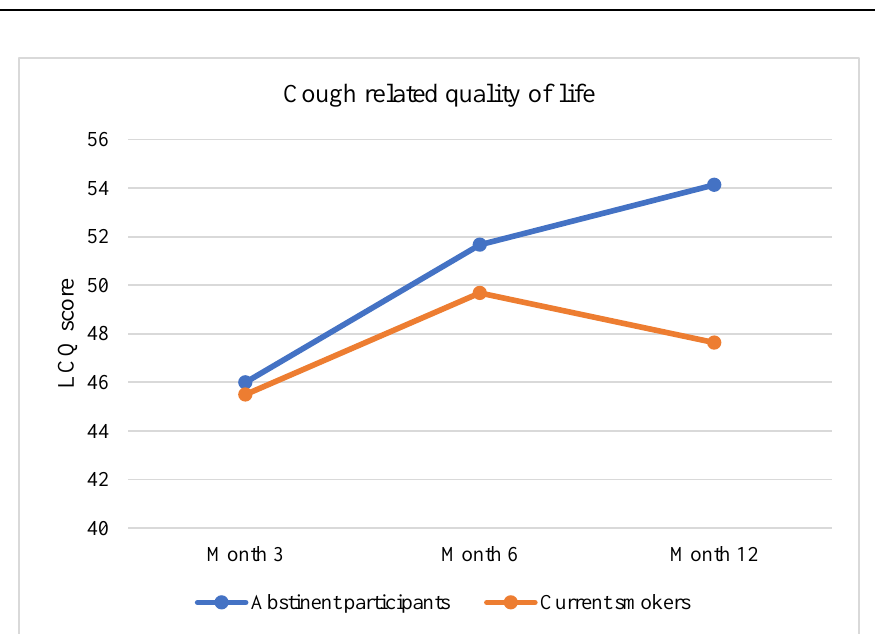
Figure 3. Change in anxiety level as measured by HAD subscale throughout the study Burning throat decreased from 6 to 12 months, which may be considered the only relevant symptom potentially related to the habitual use of e-cigarettes (Table 3). Table 3. Side-effects. Here we describe participants ’ subjective reports about e-cigarettes ’ side-ef- fects. Answers were collected through an interview by health personnel concerning the last 6 months.